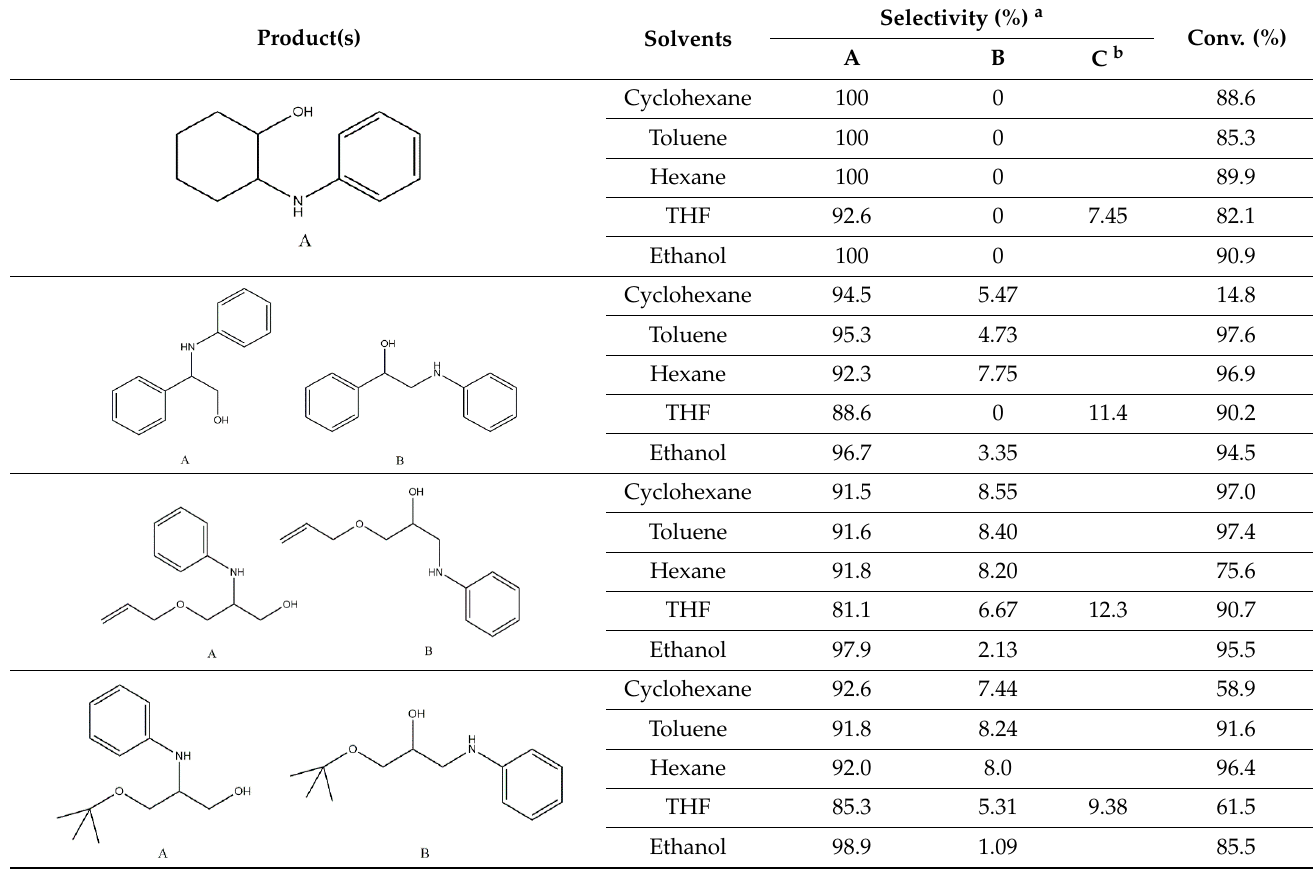
Table 2. Solvent and substrate variation.